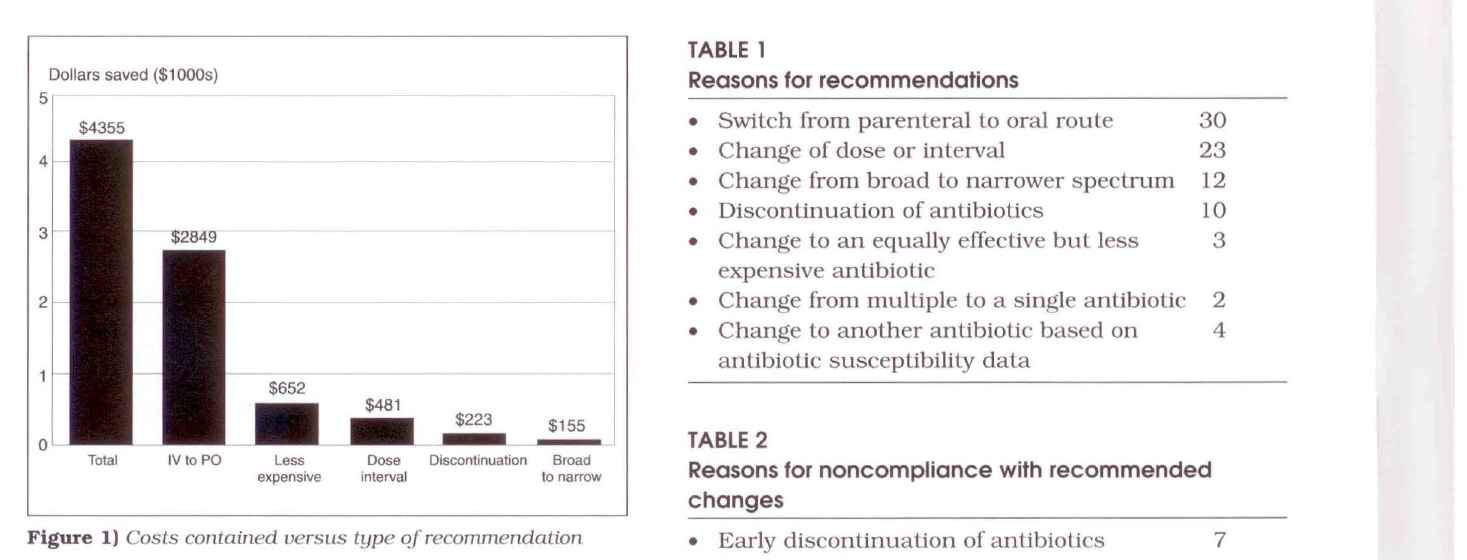
Figure 1) Cosls conlained versus type of recommendation